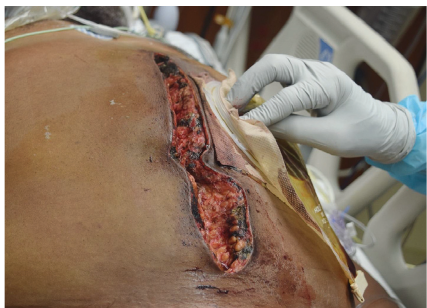
Figure 5: Photographic image of the patient’s midline abdominal closure and colostomy bag after left-sided colostomy creation for fecal diversion.